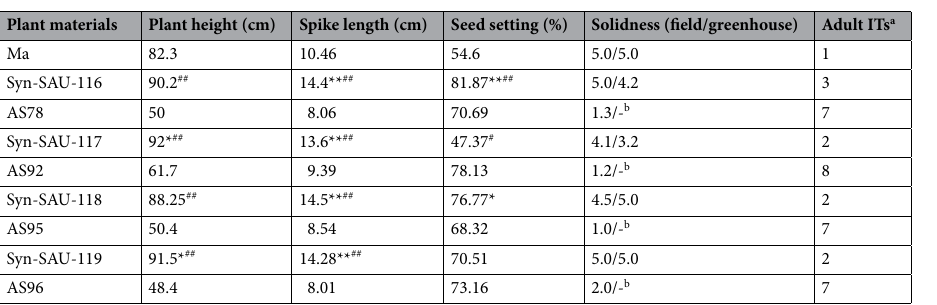
Table 2. Agronomic trait comparison of synthetic hexalpoid wheat and their parents. a the infection type to stripe rust; b no data. *Significantly different from T. durum Ma at the 0.05 level, **at the 0.01 level; # significantly different from Ae. tauschii at the 0.05 level, ## at the 0.01 level.